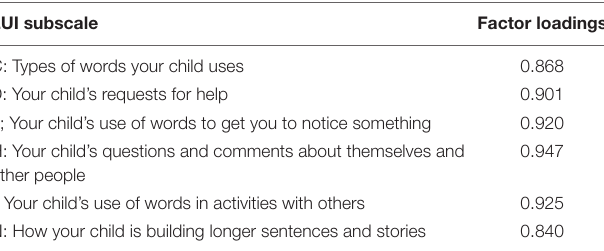
TABLE 8 | LUI-6 home language principal component analysis, rotated factor loadings. LUI subscale Factor